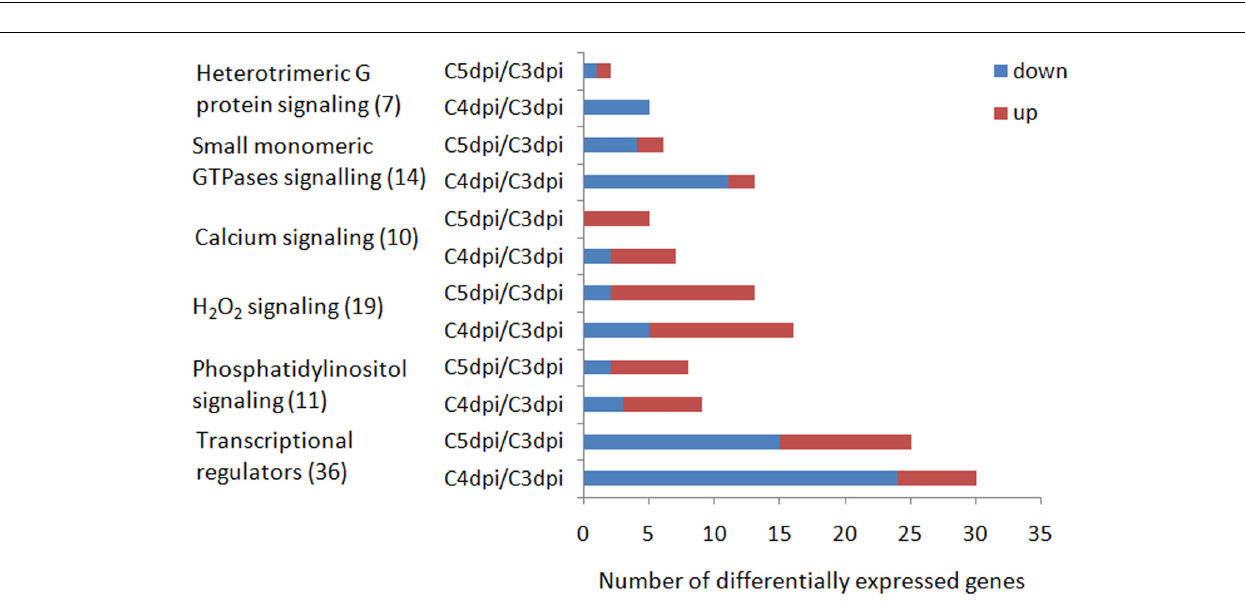
FIGURE 4 | Lugol staining of glycogen (A) and DAB (B) staining of H 2 O 2 in Bgt during asexual reproduction. Infected leaf segments were sampled at 3, 4, and 5 dpi. H 2 O 2 and glycogen can be identified as brown complex. M, mycelium; FC, foot cell; Co, conidiophore. The bars represent 50 µ m. H 2 O 2 and glycogen began to appear in the foot cells by 4 dpi and largely accumulated in the developing conidiophores by 5 dpi.